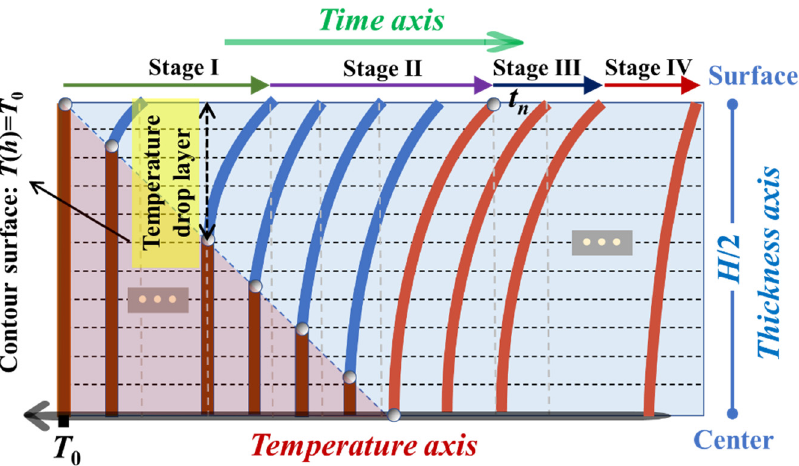
Figure 5. Temperature-distribution trends along the thickness direction of the magnesium plate at different air-cooling stages.